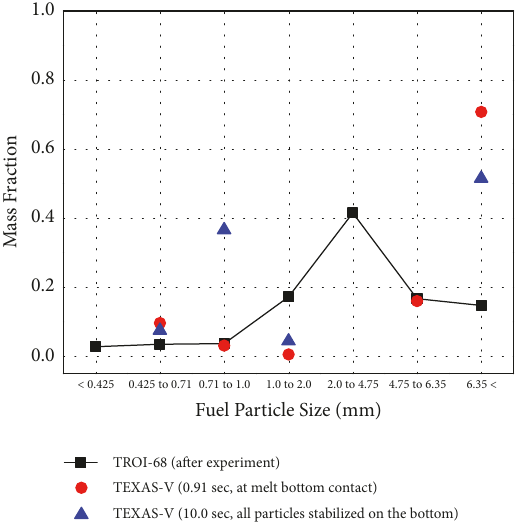
Figure 11: Particle size distribution in the condition for partially flooded cavity.